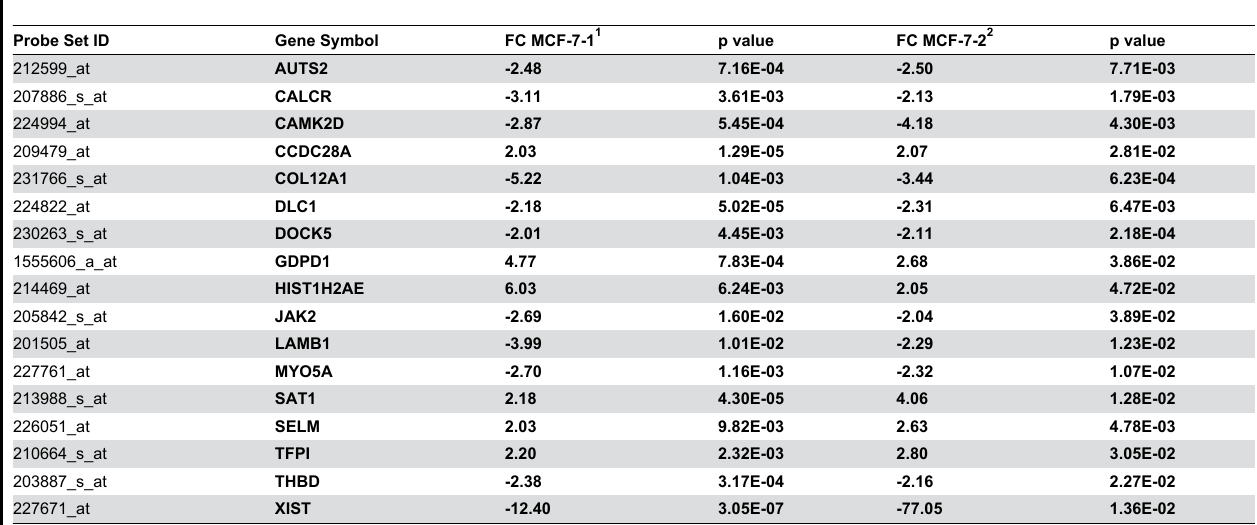
Table 8. Shared affected genes: Comparison of stable induction of ACSL4 in MCF-7 and SKBr3 cells.